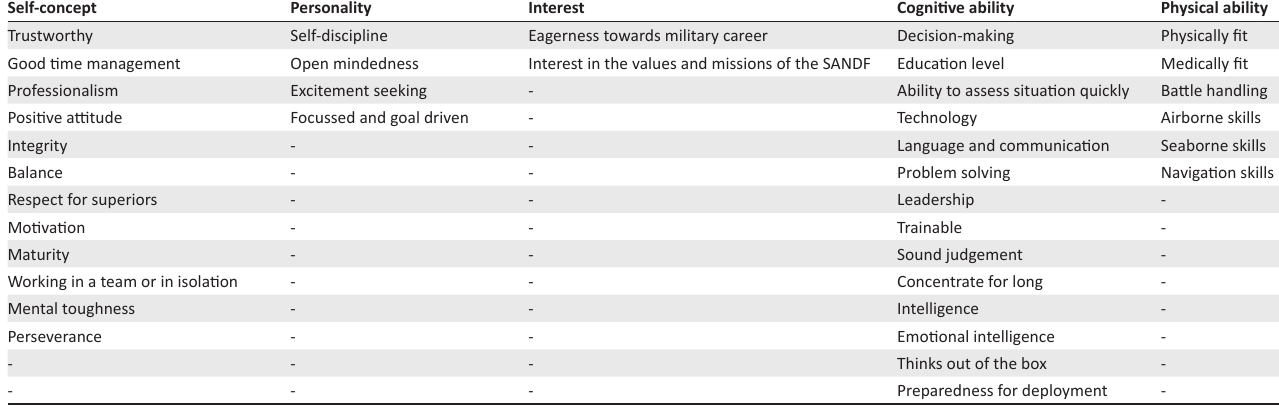
TABLE 2: Summary of factors contributing to career success.